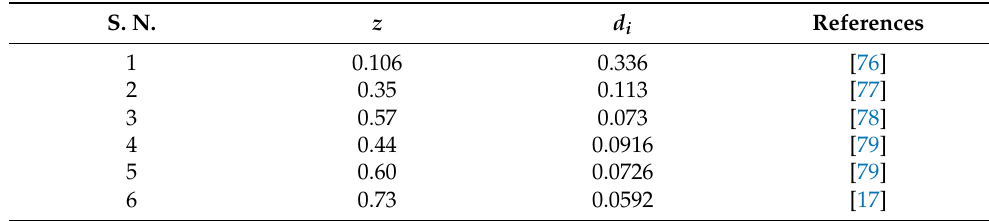
Table 1. The BAO data points which we use in our